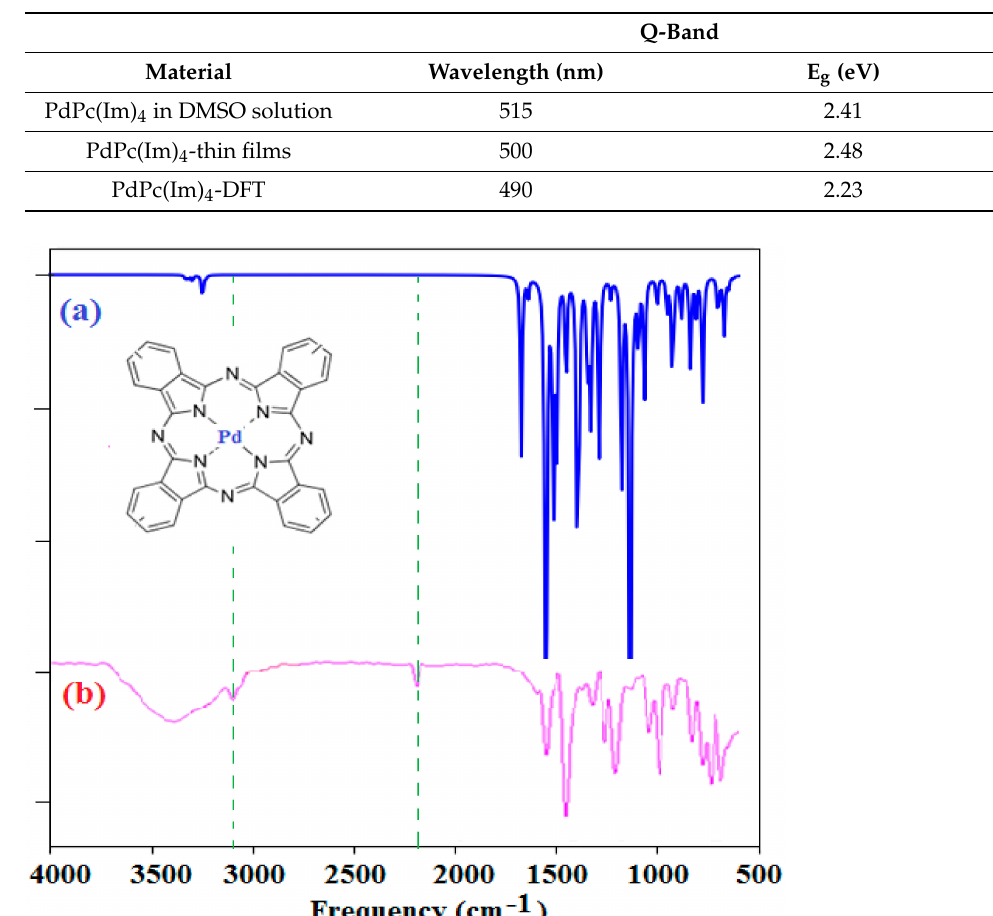
Figure 8. ( A ) Variation of absorbance using DFT and ( B ) PdPc(Im) 4 molecular orbital energies in eV. The levels to the right show degenerate energies. Table 1. Band gap and threshold wavelengths value for PdPc(Im) 4 in DMSO solution, PdPc(Im) 4 -thin films, and PdPc(Im) 4 -DFT.